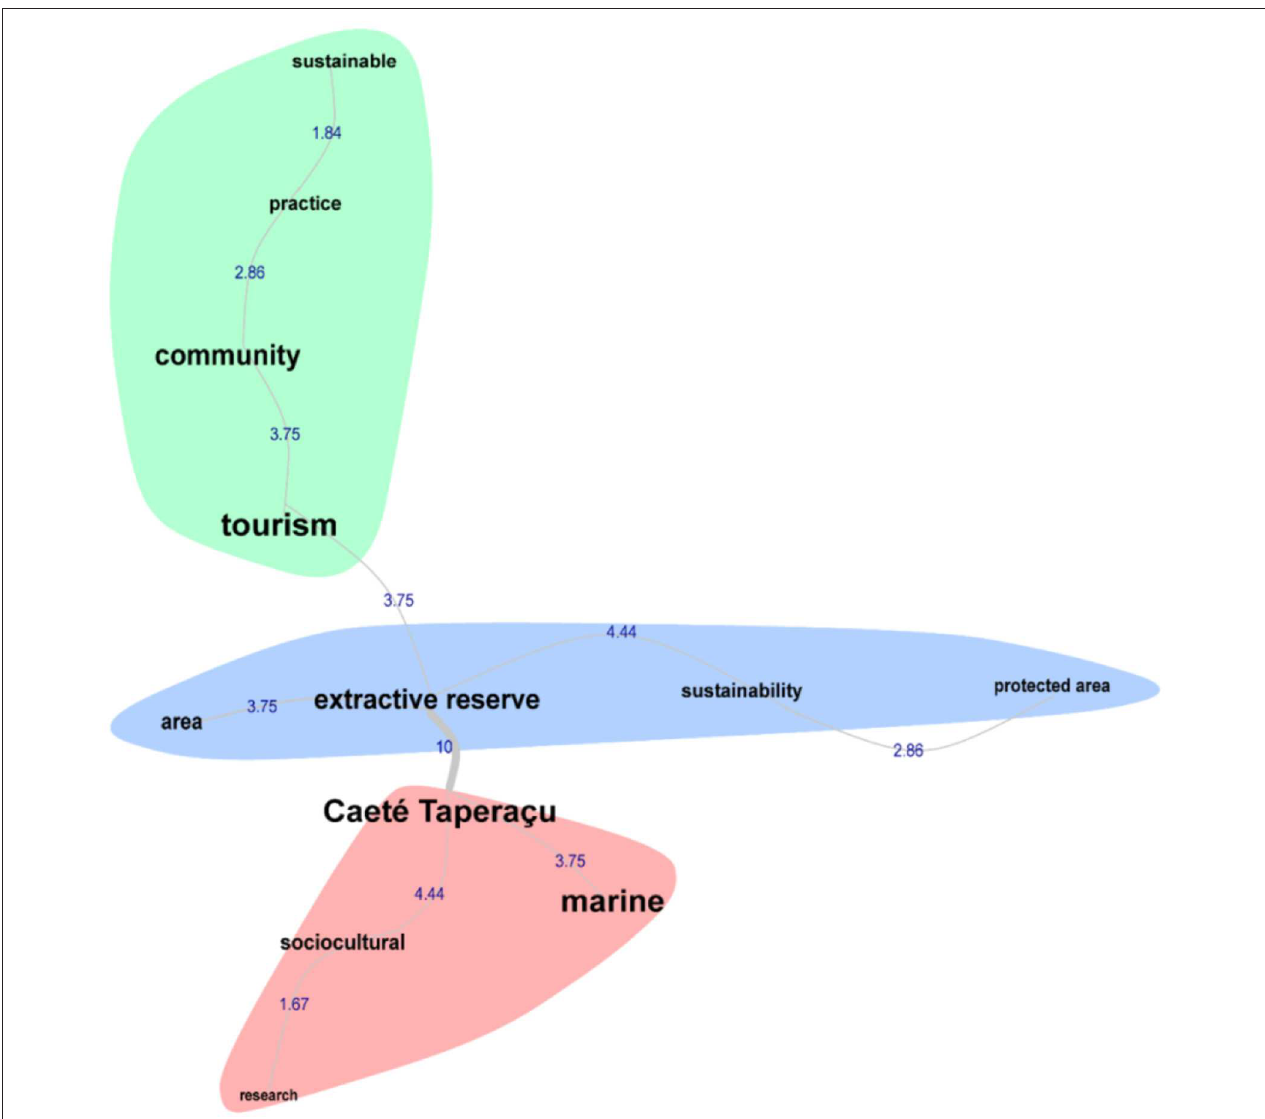
FIGURE 7 | Similarity analysis of local case study text. The numbers represent the proximity, and indicate the distance between the words based on frequency and similarity. The largest words are most frequently mentioned. These words are interconnected by frequency, based on the theory of graphs and networks. The colors represent the classes, which were established according to the proximity of the words in the texts. This similarity analysis is related to the DHA in Figure 8